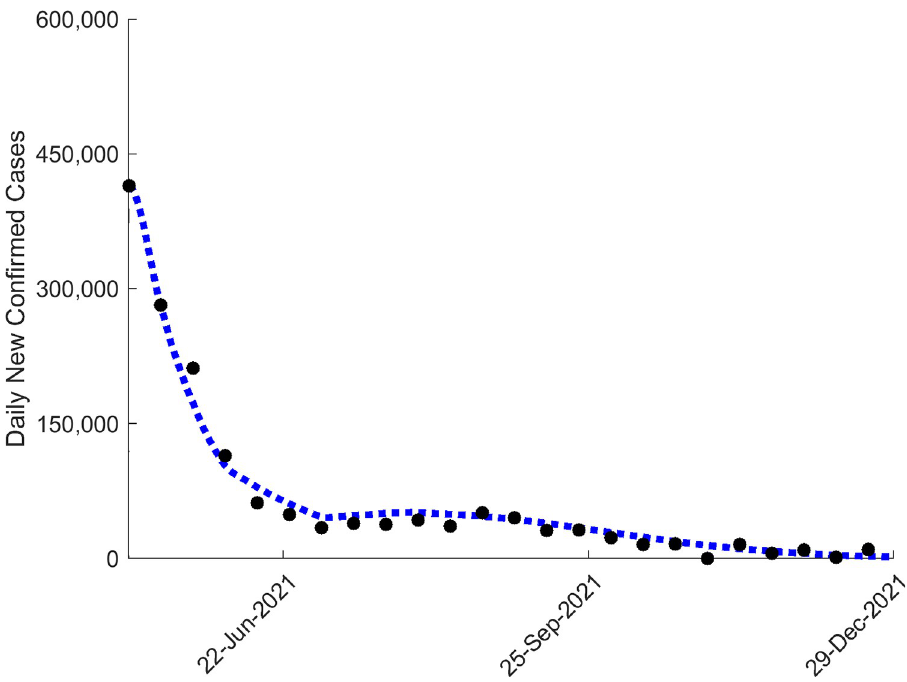
Fig 5. Long-term median prediction for daily new confirmed cases for the 60-day period of social restrictions with a 3x ramping of vaccinations and a phased imposition of high (60% reduction in transmission) in month one followed by a less stringent moderate (35% reduction in transmission) level of social measures in month